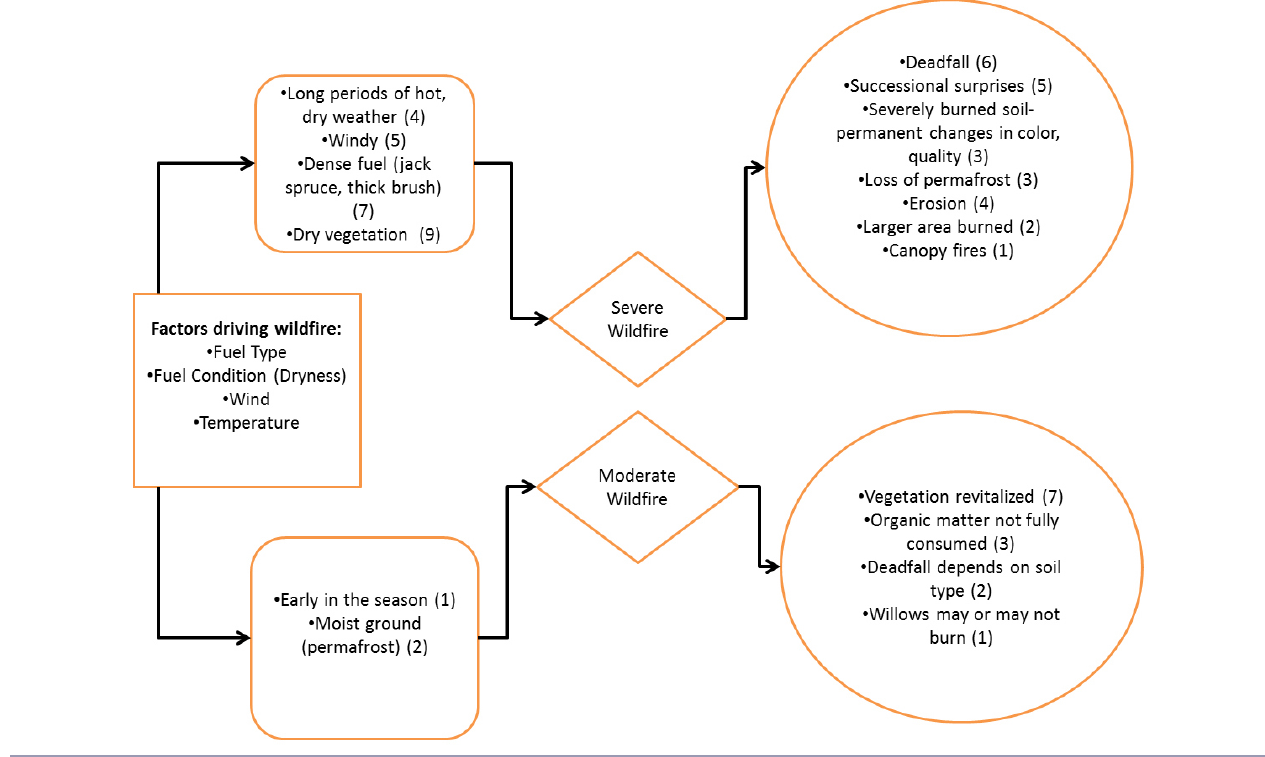
Fig. 2 . Koyukon respondent descriptions of factors influencing wildfire severity and resultant effects on resources. Note that the numbers in parentheses refer to the number of respondents who provided that